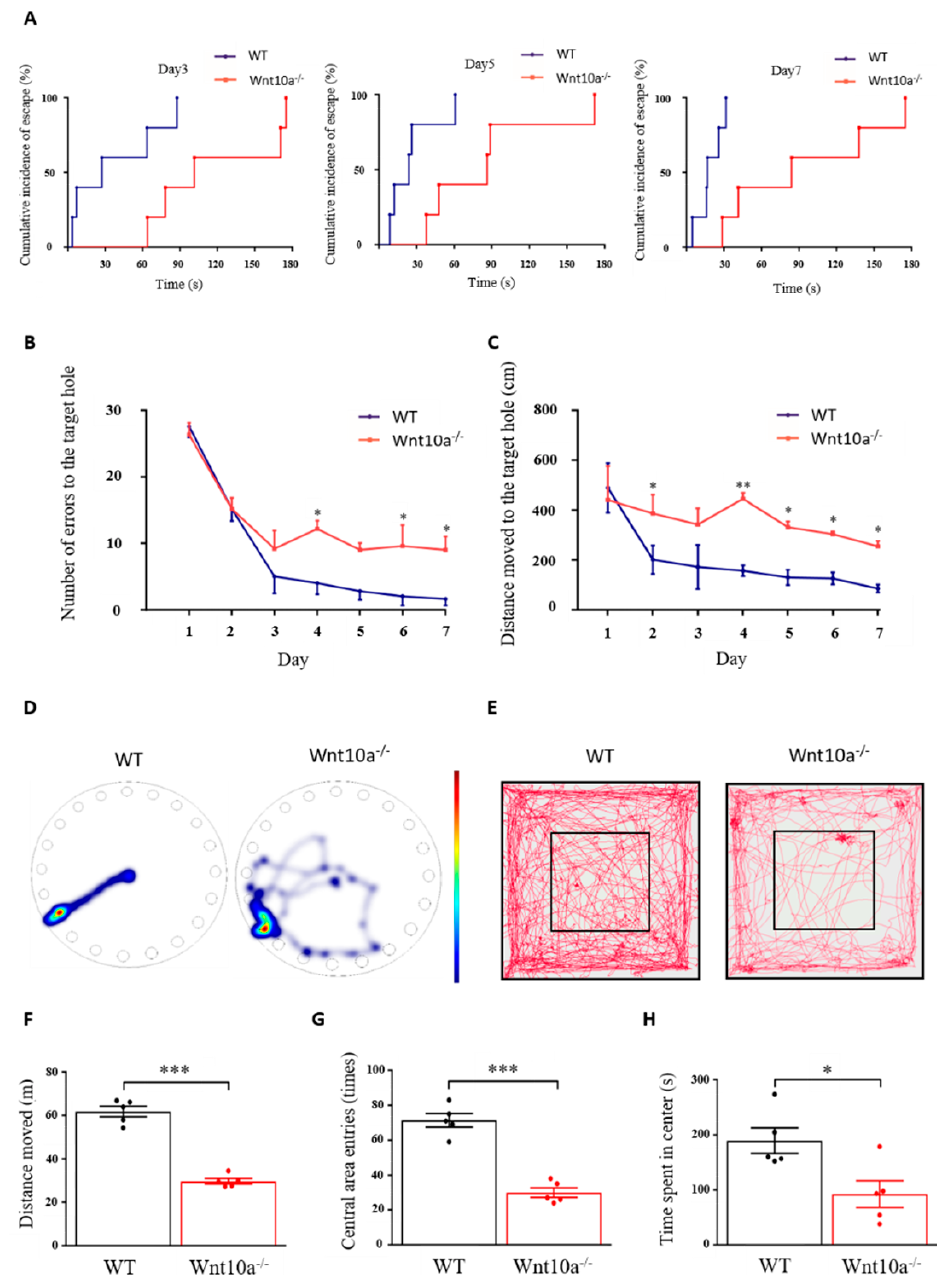
Figure 2. Spatial memory and behavior in Barnes maze and open field tests. The cumulative incidence of latency was longer in Wnt10a -/- mice compared with WT mice ( A ). The number of errors to the target hole ( B ) was significantly higher, and the distance moved to the target hole ( C ) was significantly increased in Wnt10a -/- mice compared with WT mice. Representative heatmap images showing tracking data on the final trial day ( D ) and representative movement tracks in the open field test ( E ). The total distance moved, the central area entries, and the time spent in the center were significantly decreased in Wnt10a -/- mice compared with WT mice ( F – H ). Data are expressed as mean ± SEM; n = 5/group; * p < 0.05, ** p < 0.01, and *** p < 0.001.